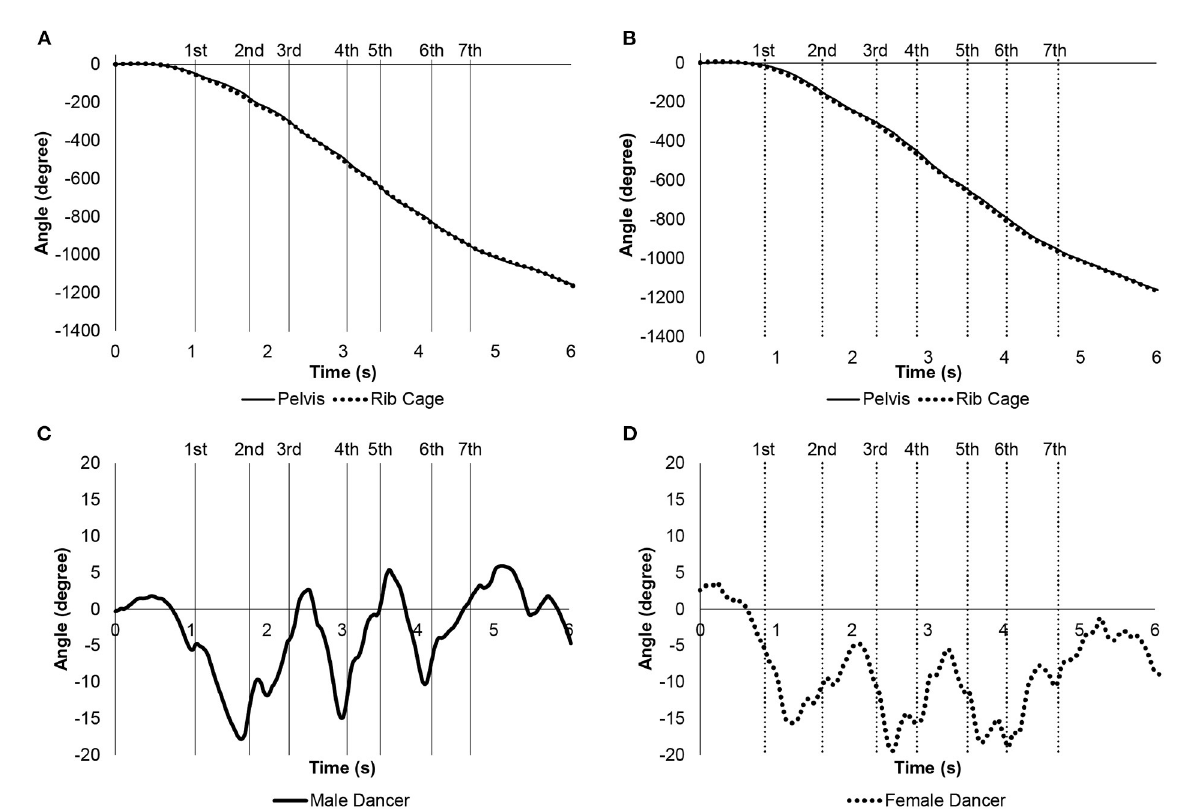
FIGURE4 Euler angles of pelvic and rib cage segments in vertical axis, representative example for the control group male and female dancers. The vertical line is the timing when the maximum value of each step for the control group male and female dancers is reached. (A) Angles of the control group male dancer. Solid line is pelvic segment. Dotted line is rib cage segment. (B) Angles of the control group female dancer. Solid line is pelvic segment. Dotted line is rib cage segment. (C) Relative angles of the rib cage segment with respect to the pelvic segment for the control group male dancer. Positive values at the relative angles indicated that the rib cage segment rotates to the left and negative values rotate to the right with respect to the pelvic segment. (D) Relative angles of the rib cage segment with respect to the pelvic segment for the control group female dancer. Positive values at the relative angles indicated that the rib cage segment rotates to the left and negative values rotate to the right with respect to the pelvic segment.